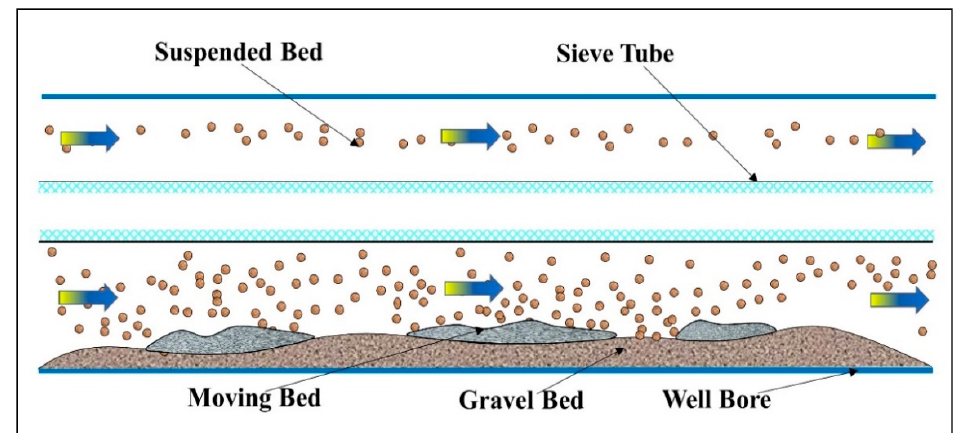
Figure 5. Schematic diagram of the three-layer hydraulic flow pattern during gravel migration process.